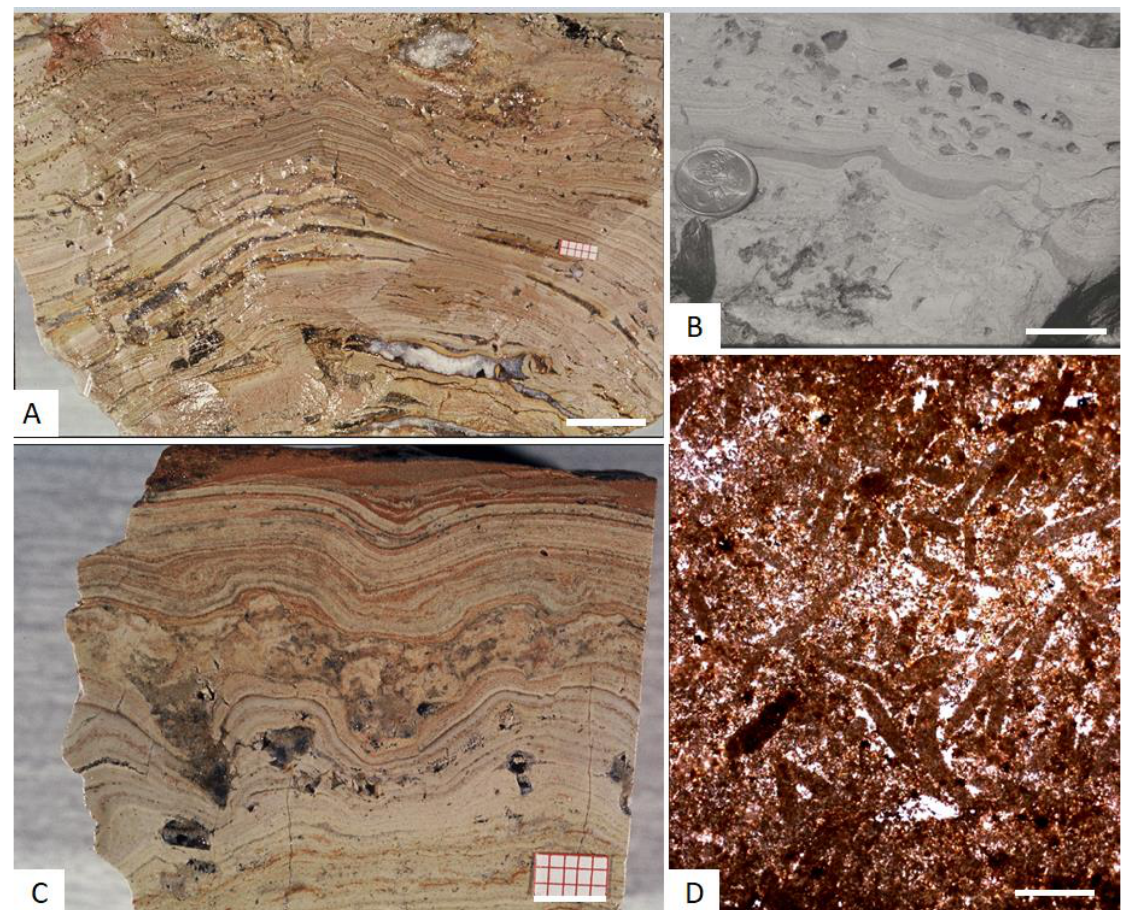
Figure 1. Representative images of Montevive stromatolites. ( A ) Laminated stromatolite. Coarse- crystalline, sparry calcite fills in desiccation cracks parallel to lamination. Scale bar: 1 cm. ( B ) Stromatolite exhibiting molds of small prismatic and lenticular gypsum. Scale bar: 2 cm. ( C ) Stromatolite with a clear selenite mold visible on the left. Scale bar: 5 mm. ( D ) “Macrofilaments” embedded in a micro sparry calcite matrix. Scale bar: 200 µm.